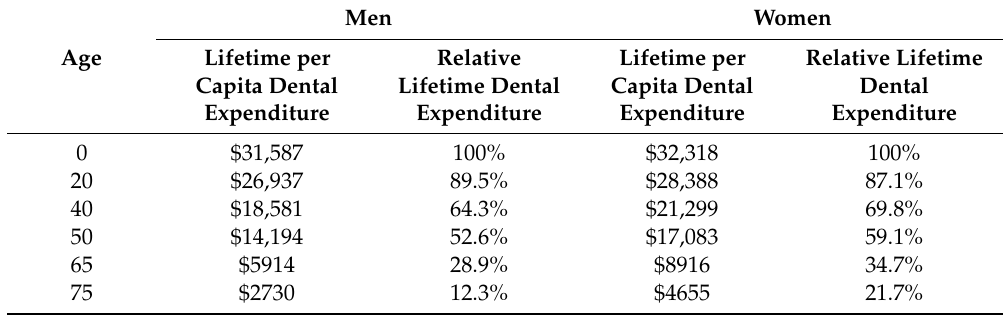
Table 2. Per capita lifetime dental expenditures of average life table and the relative lifetime dental expenditures for men and women.